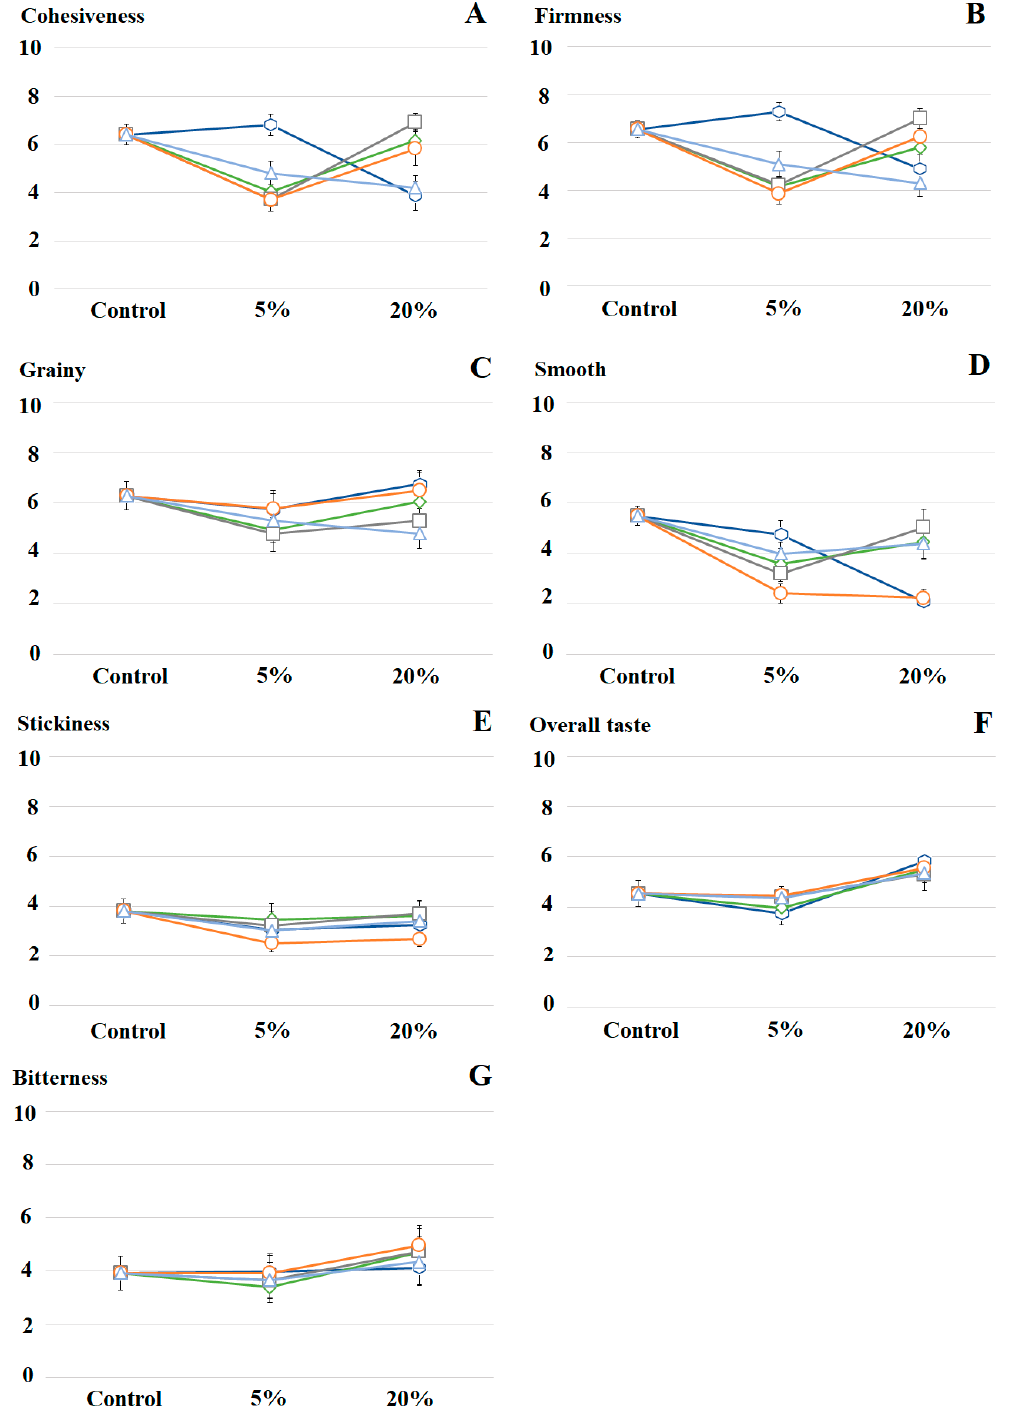
Figure 4. Sensory profiles of buckwheat-based pasta containing quinoa var. kuchivila (blue, ⬡ ), mistura (green, ◊ ), rosada taraco (gray, ▢ ), negra collana (orange, ○ ), titicaca (light blue, △ ). Sensory attributes tested: Cohesiveness ( A ), firmness (B), grainy ( C ), smooth ( D ), stickiness ( E ), overall taste ( F ) and bitterness ( G ). Corresponding dataset and raw data in Suplementary Materials (Tables S3 and S4). Error bar shows ± standard error